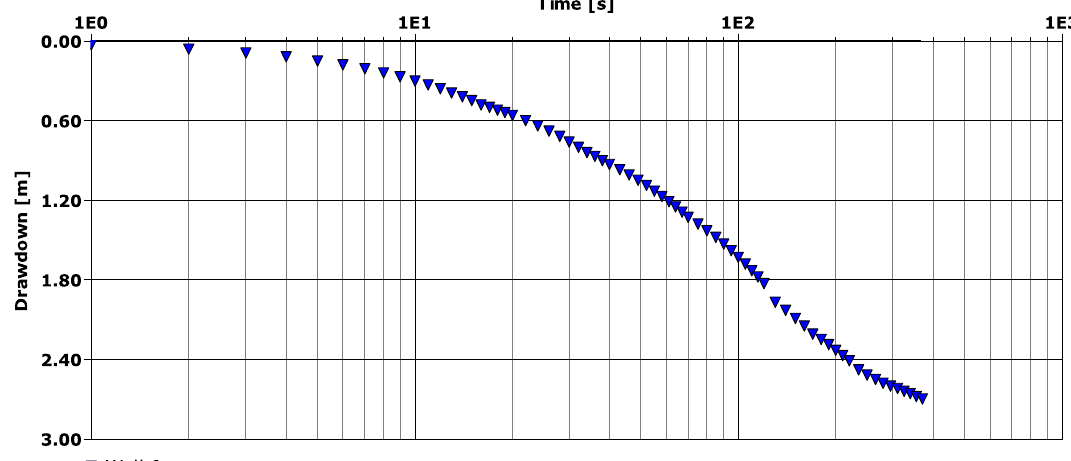
Fig. 26 Theis’s method of pumping